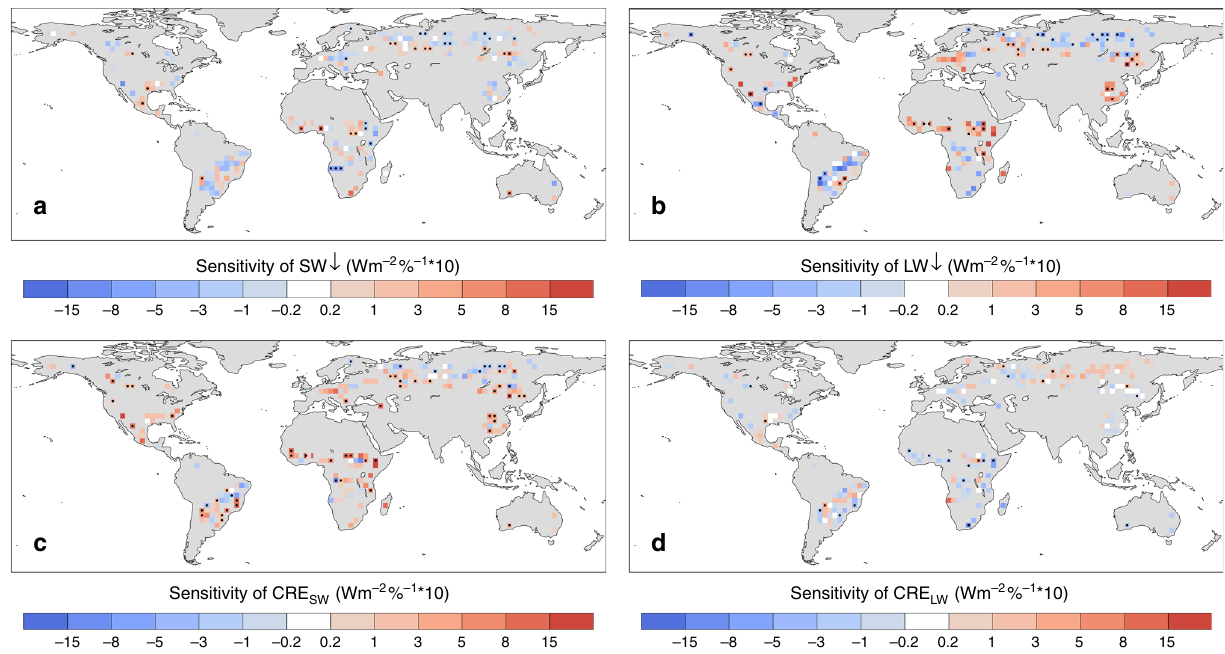
Fig. 5 Observed sensitivity of radiation and cloud radiative effects to deforestation. a Clear-sky downward shortwave (SW ↓ ), b clear-sky downward longwave (LW ↓ ) radiation, and the cloud radiative effects on net c shortwave and d longwave radiation. The sensitivity is calculated based on the Clouds and the Earth ’ s Radiant Energy System (CERES) data within a 3° × 3° analysis window. The black dot signs indicate the sensitivity is signi fi cant at a false discovery rate (FDR) adjusted p values of